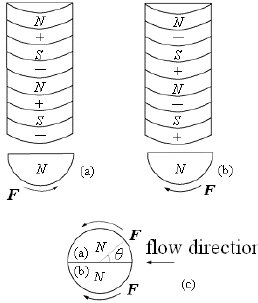
Figure 1. Lorentz force on the cylinder surface.